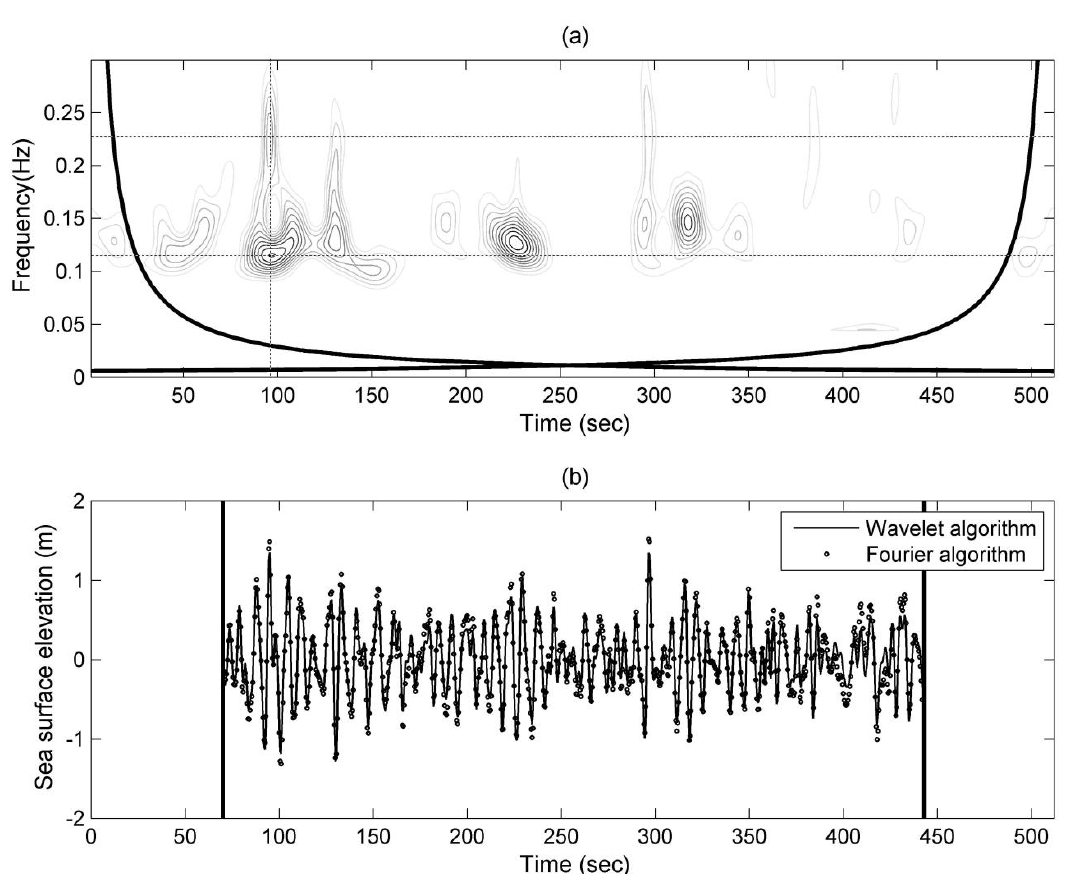
Figure 8. ( a ) A Wavelet spectrum of sea surface elevations; ( b ) Sea surface elevations derived from acceleration signals of wave buoy. The significant wave height and mean wave period of this record are 1.6 m and 5.8 s, respectively. During the period of between 90 s and 100 s of wavelet spectrum, the highest and 2nd highest peaks of energy distribution are located at around 0.115 Hz and 0.23 Hz, respectively. The horizontal dash lines in Figure (a) indicate the corresponding frequencies of two